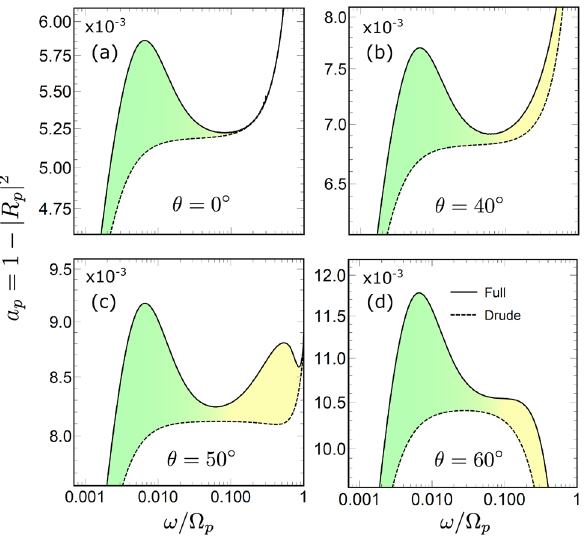
Figure 2. Frequency dependence of the absorptivity a p for p -polarized waves, calculated for incident angle 0 40 50 60 values of θ ◦ ( a ), ◦ ( b ), ◦ ( c ), and ◦ ( d ). Results for the LRS model in Eq. (4) are given by the solid like = ”Full”, the Drude approximation is shown by the dashed line ”Drude”. Green/yellow colour filling represents the ASE/SASE frequency